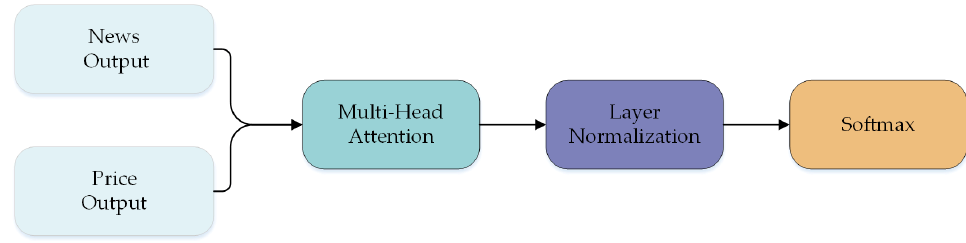
Figure 4. Merged